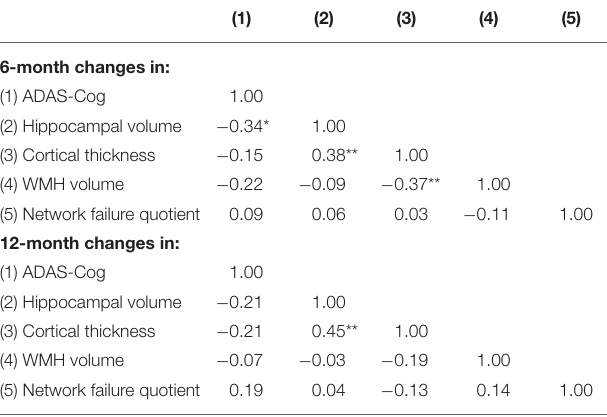
TABLE 3 | Pairwise correlation coefficients between changes in MRI biomarkers and changes in cognition over 6 and 12